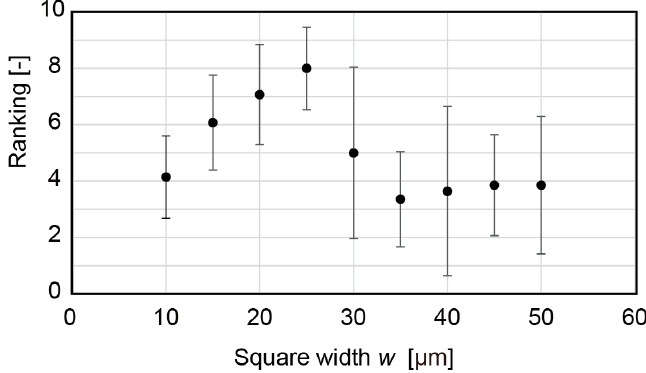
Figure 7. Ranking of dry perception for various square patterns. Table 2. Statistical significance in dryness perception between samples with w values of 15 and 25 µ m. N.S. means not significant.